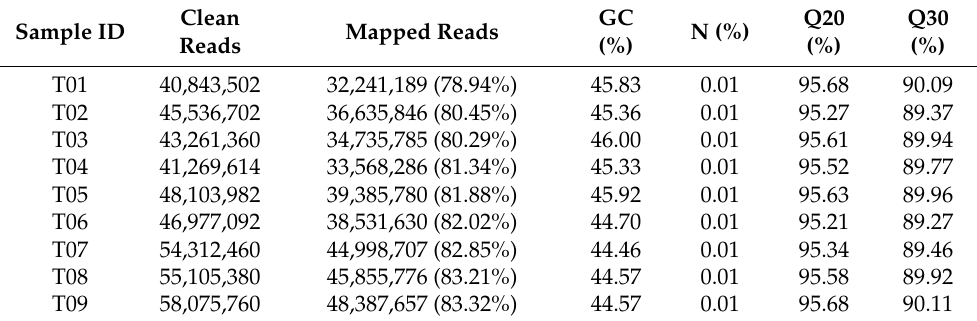
Table 1. Summary of sequencing